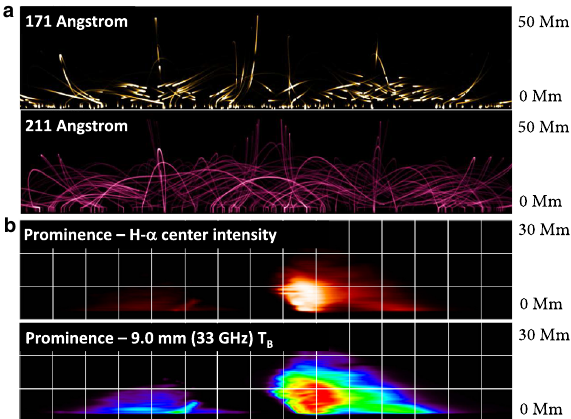
Fig. 19 Fine structure associated with prominences can be modeled within a 3D magnetic structure. a Snapshots of time-varying coronal emission at (top) 171 Å and (bottom) 211 Å, for a 1D multithread simulation of TNE in a 3D sheared arcade (from Luna et al. 2012). b Prominence fine structure in (top) H α emission and (bottom) 9.0 mm (33 GHz) brightness temperature determined from plasma in 1D hydrostatic equilibriumalongfieldlineswithina3DNLFFmagneticmodel(fromGunáretal.2016).Imagesreproduced with permission, copyright by